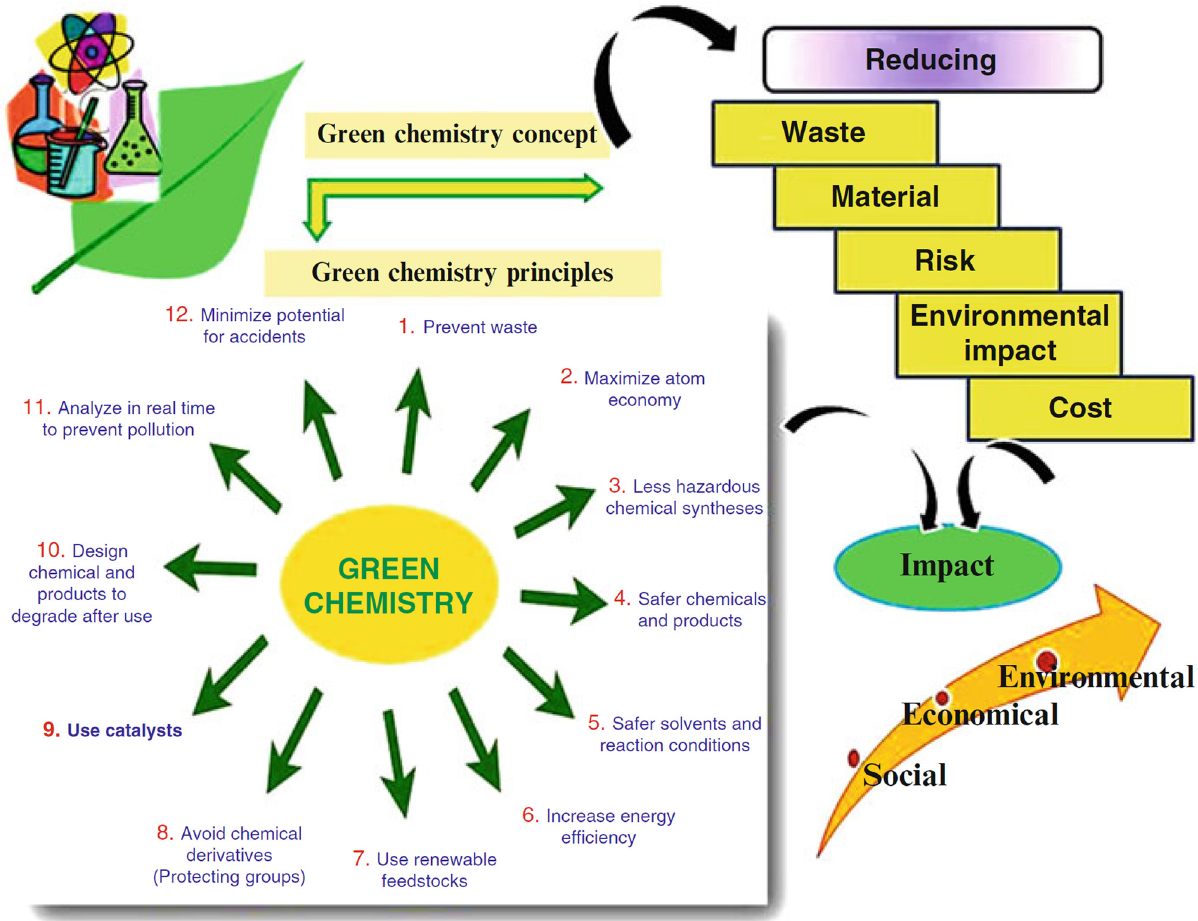
Figure 2: Schematic exempli fi cation of green chemistry combination in metal nanomaterials cloning [ 27 ]